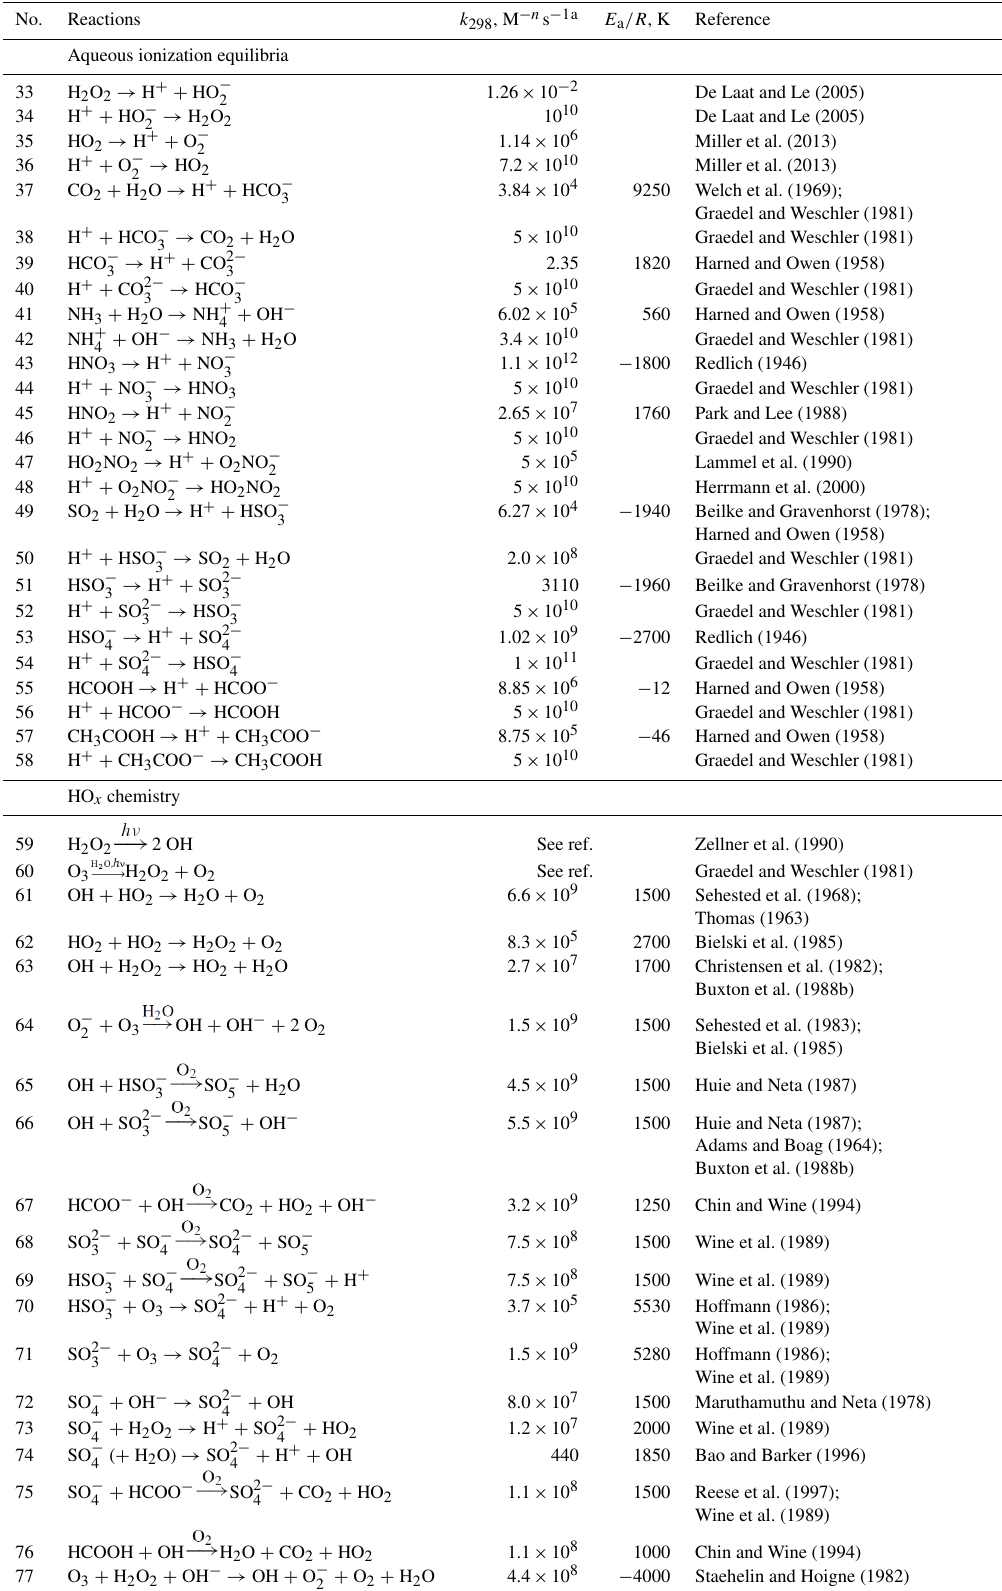
Table 2. Aqueous-phase chemistry. No.